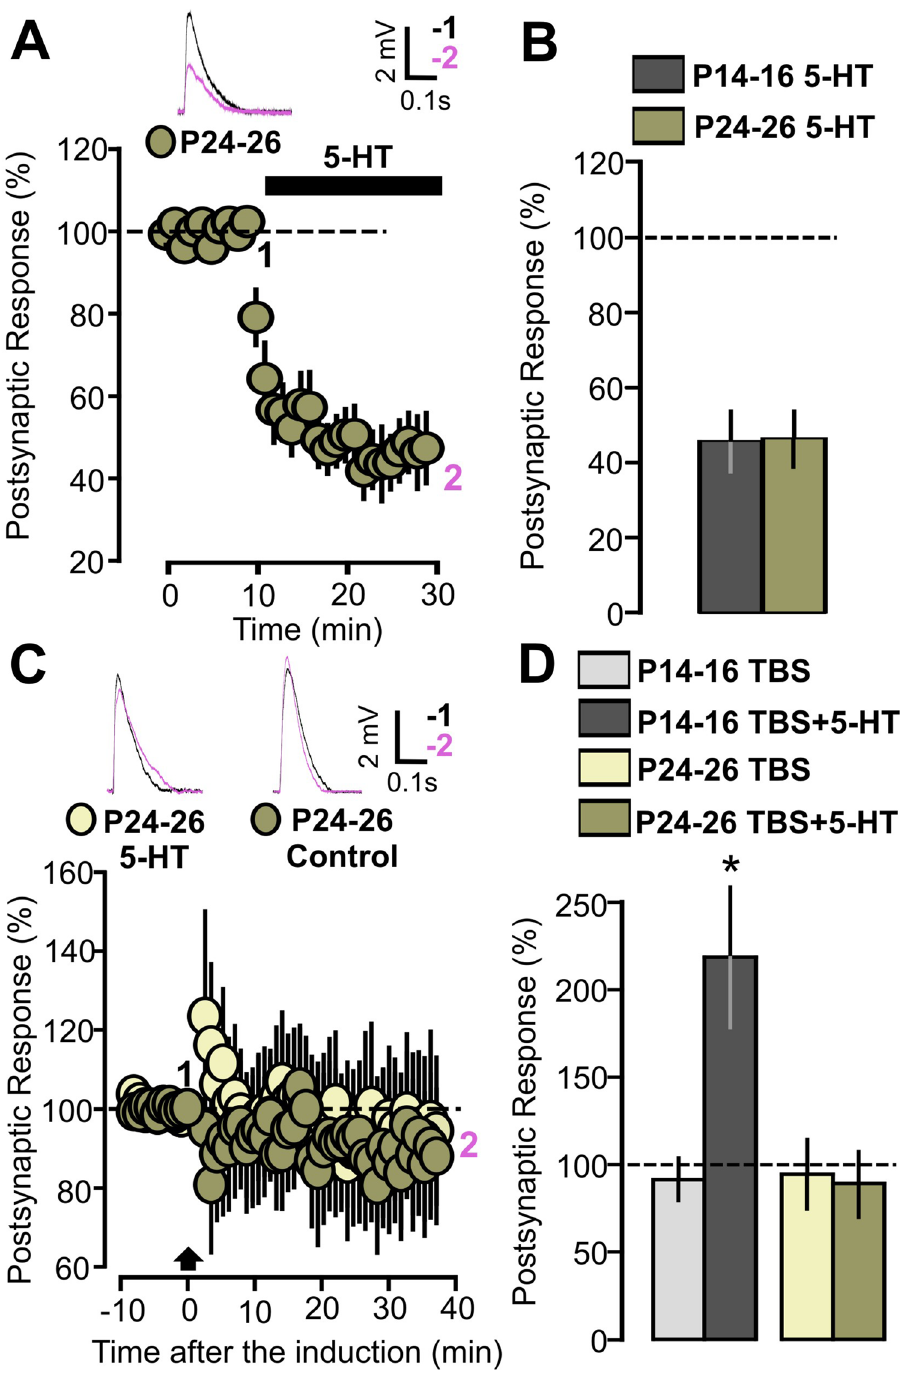
Figure 10. TBS induction fails to induce synaptic plasticity in slices from P24-26 animals. ( A ) The graph shows the EPSPs recorded in P24-46 animals before and during 5-HT bath application. The EPSPs were normalized to the mean of responses recorded during the baseline. The black bar represents the period of application of 5-HT (50 µM) in the bath. Traces show the results of a representative experiment with the average of postsynaptic responses recorded before (1: 5 to 10 min, black line) and after (2: 25 to 30 min, magenta line) application of 5-HT. ( B ) Graph showing the effects of 5-HT on the averaged post synaptic responses for the 25–30 min period in P14-16 and P24-26 animals. EPSPs were normalized to the mean of responses recorded during the baseline. ( C ) The graph shows the EPSPs recorded in P24-26 animals before and after TBS induction. The EPSPs values were normalized to the mean of responses recorded during the baseline, with two different conditions being compared: control (yellow inserts) and 5-HT (brown inserts, 50 µM). Traces show the results of a representative experiment with the average of postsynaptic responses recorded before (1: baseline, − 5 to 0 min, black line) and after the TBS induction (2: post induction, 35–40 min, black line). ( D ) Graph showing the averaged EPSPs recorded during the 35–40 min period after TBS induction. Four experimental groups are compared (P14-16 TBS, P14-16 TBS + 5-HT, P24-26 TBS, P24-16 TBS +